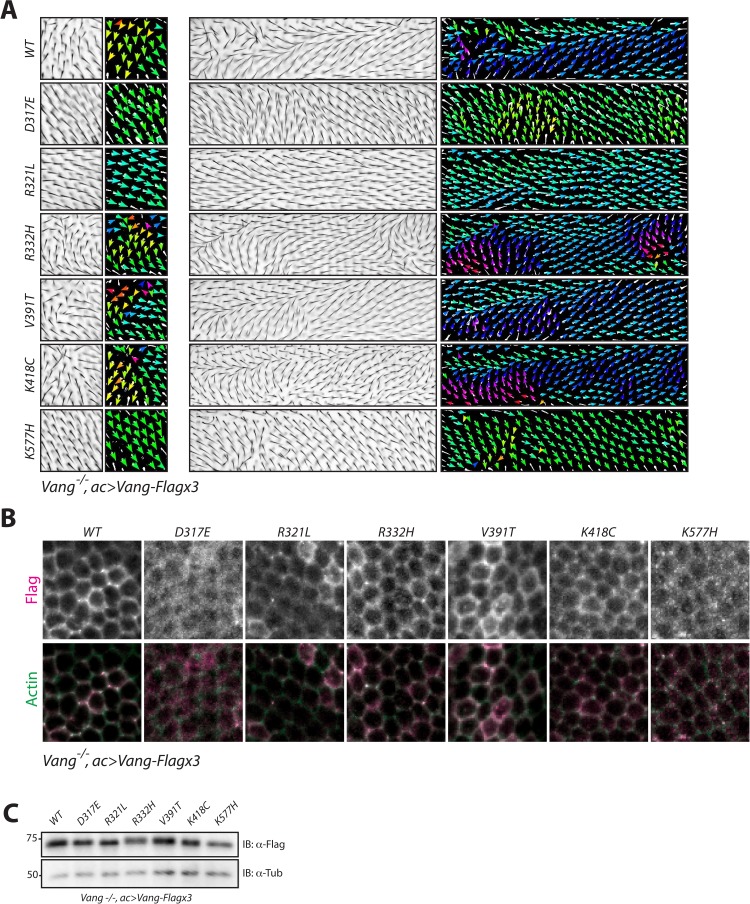
NTD mutations affect membrane localization of Vang.(A) Regions 1 and 2 of the adult wing (see Figure 2A) showing hair reorientation phenotypes in the indicated genotype. Note similarity in pattern between WT, R332H, V391T and K418C mutants (swirls, cf. GOF in Figure 2—figure supplement 1), as compared to R321L (wild-type orientation), and D317E and K577H (downwards reorientation, cf. LOF in Figure 2—figure supplement 1). Color range is same as in Figure 2. (B) Representative immunofluorescence images of pupal wings upon expression of Vang-Flag or indicated mutant Vang proteins using actin-Gal4 driver. Note changes to Vang localization as shown through Flag staining (red), and the degree of overlap with actin (stained with Phalloidin, green) which marks the membrane (C) Western blot of wing discs from the indicated genotypes. Note that all transgenes were expressed at similar levels. Differences in mobility are also observed as in Figure 2 and Figure 2—figure supplement 1.